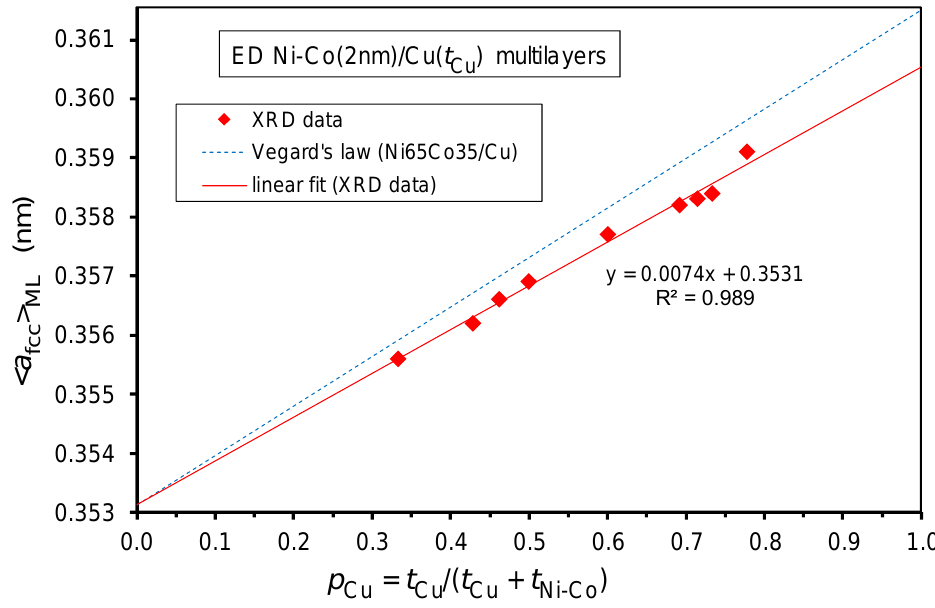
Figure 6. Average lattice parameter < a fcc > ML in the multilayer stack as determined from the position of the (111) Bragg reflection vs. fractional thickness p Cu of the non-magnetic (Cu) layer for the present electrodeposited (ED) Ni65Co35/Cu multilayers (full diamond symbols). The solid line is a linear fit to the data. The dashed line corresponds to the “multilayer” Vegard’s law for these multilayers [45,67].